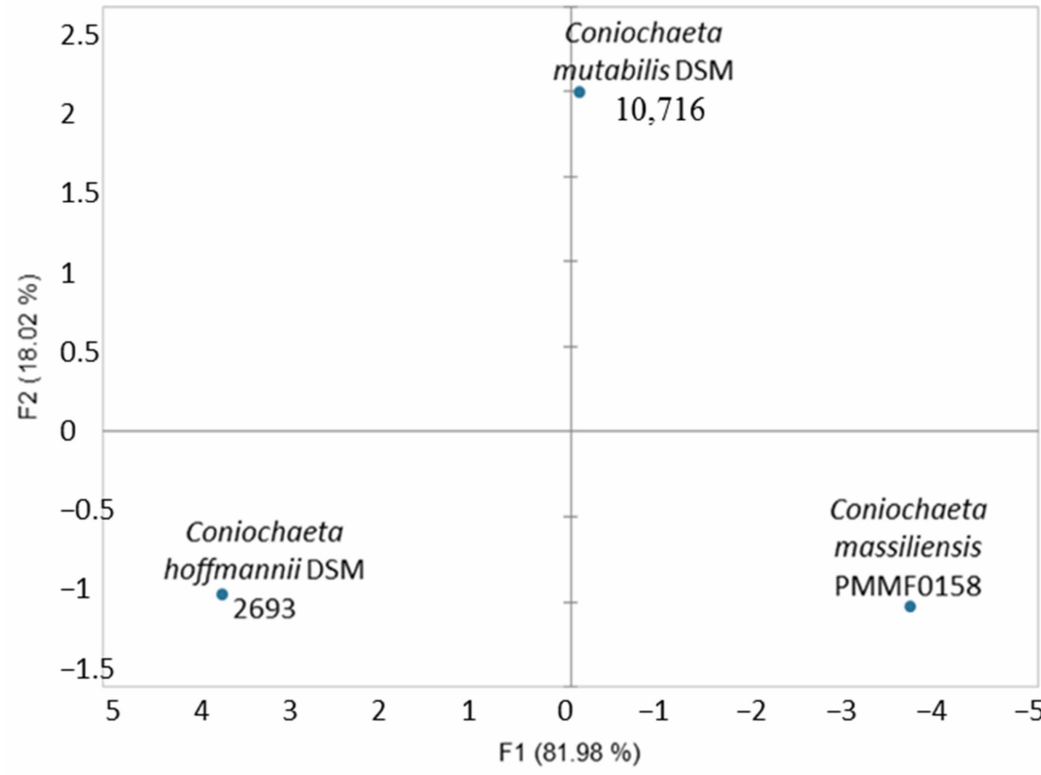
Figure 3. Principal component analysis (PCA) processed with the XLSTAT software of the energy- dispersive X-ray spectroscopy chemical mapping profile, performed for the novel species Coniochaeta massiliensis (PMML0158) and two reference strains in the genus. The principal components F1 and F2 explained 100% of the chemical mapping profile